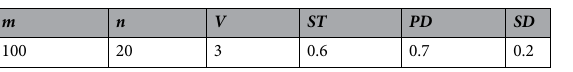
Table 1. Parameter initialization settings for SSA algorithm